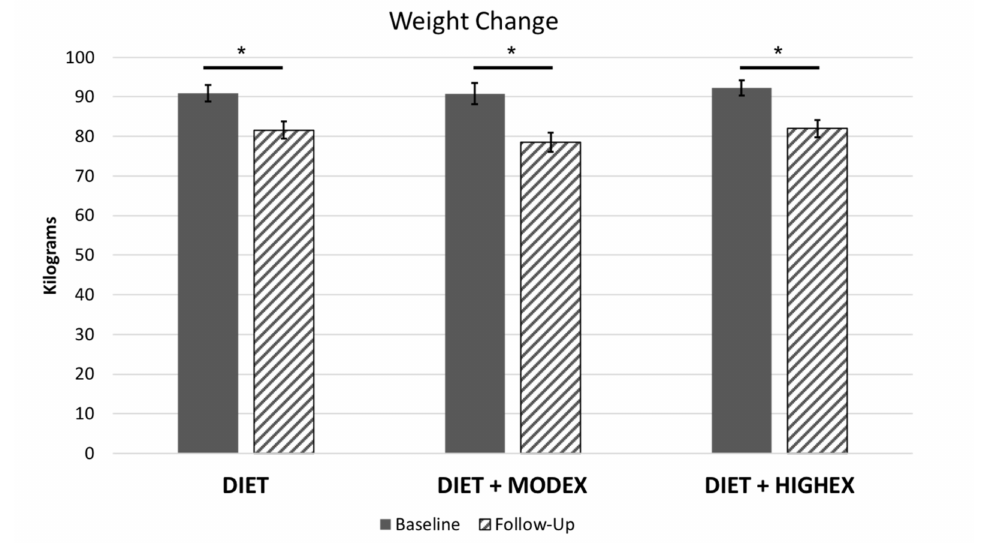
Figure 1. Intervention e ff ects on weight (kg), separated by group assignment. Error bars represent standard error. Note: * indicates that the comparison was significant at the p < 0.05